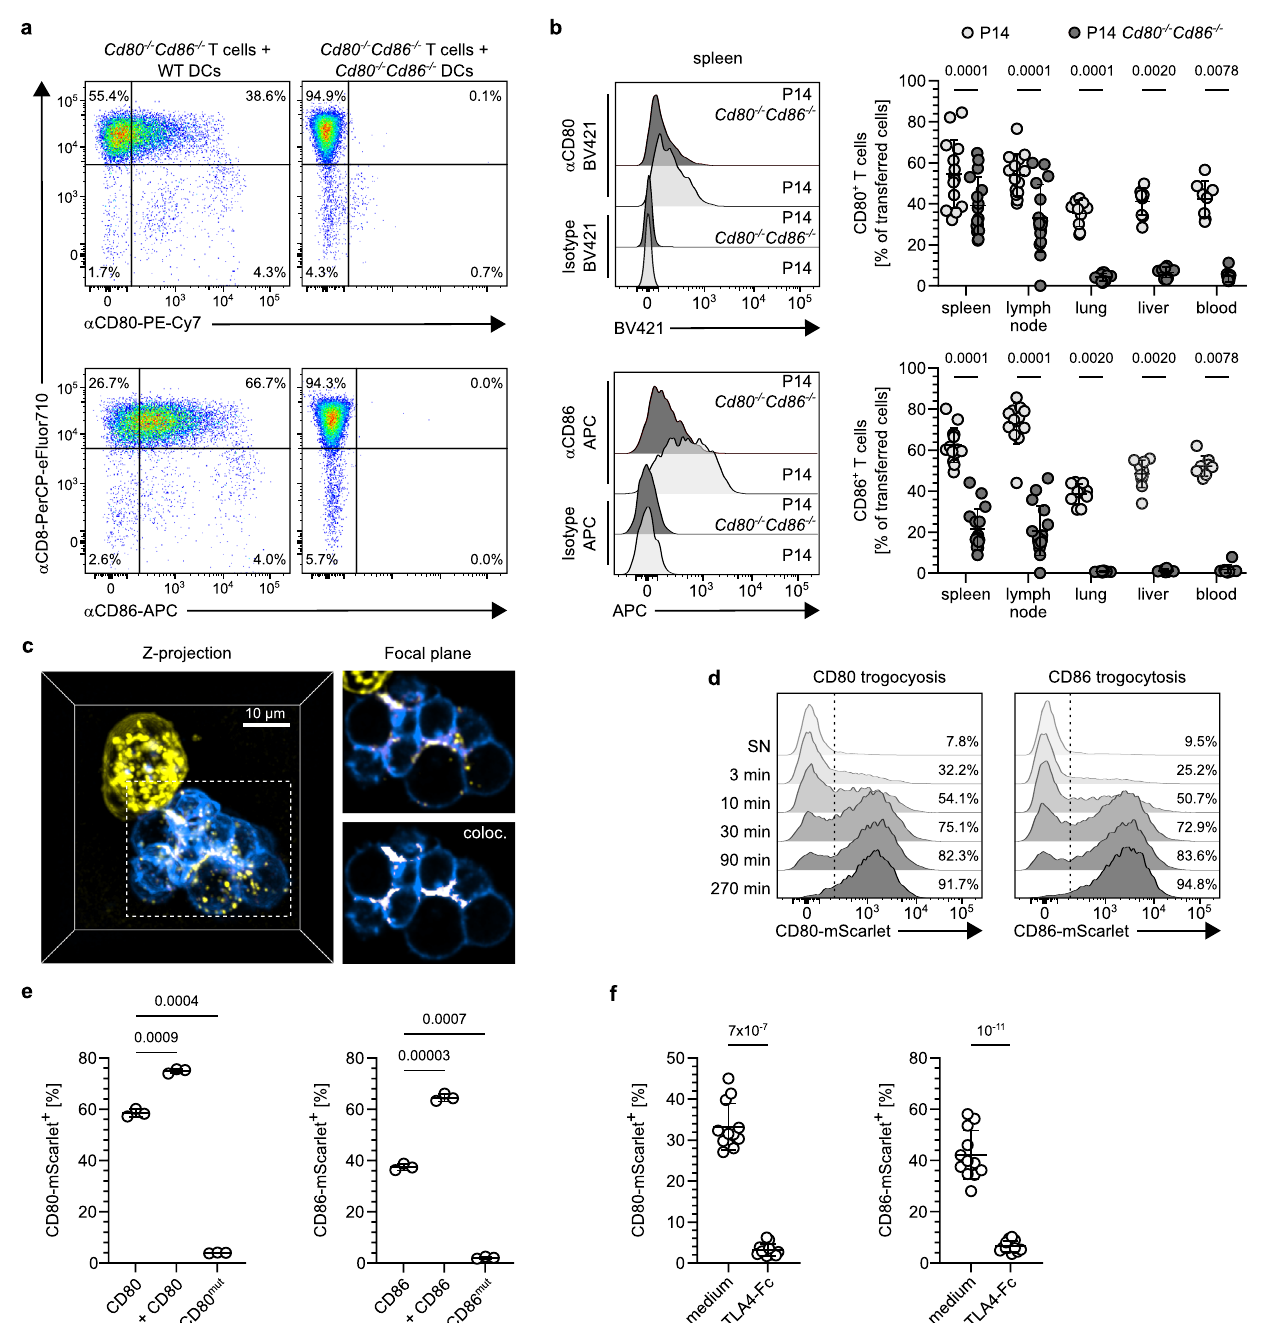
Fig. 1 | T cells acquire CD80 and CD86 from neighboring cells. a CD80- and CD86-surfacestainingof Cd80 − / − Cd86 − / − P14CD8 + Tcellsco-culturedwithwild-type (WT) or Cd80 − / − Cd86 − / − antigen-loaded DCs. Gating: Thy1.2 + CD44 + T cells. b CD80 and CD86 staining of WT and Cd80 − / − Cd86 − / − P14 T cells on day 12 post LCMV- infection. Left: representative histograms of transferred T cells. Right: Proportion of CD80 + or CD86 + cells. LN denotes lymph nodes. c Z-projection (left) and focal plane(right)ofmembrane-TomatoP14CD8 + Tcells(blue)co-culturedfor48hwith CD80-TagGFPtransgenic,antigen-loadedMEFs(yellow).Bottomrightimagesolely depicts CD80 co-localizing with T cell membrane. Scale bar 10 µ m. d Acquisition kinetics of CD80 and CD86 by P14 CD8 + T cells upon co-culture with CD80- or CD86-mScarlet-transgenic, antigen-expressing MEFs or their respective super- natants(SN). e ProportionsofP14CD8 + TcellsacquiringCD80orCD86co-cultured with MEFs expressing native CD80- or CD86-mScarlet or mutants thereof (CD80 Y201A, CD86 Q35A) with or without antigen-loading. f Blockade of intercellular